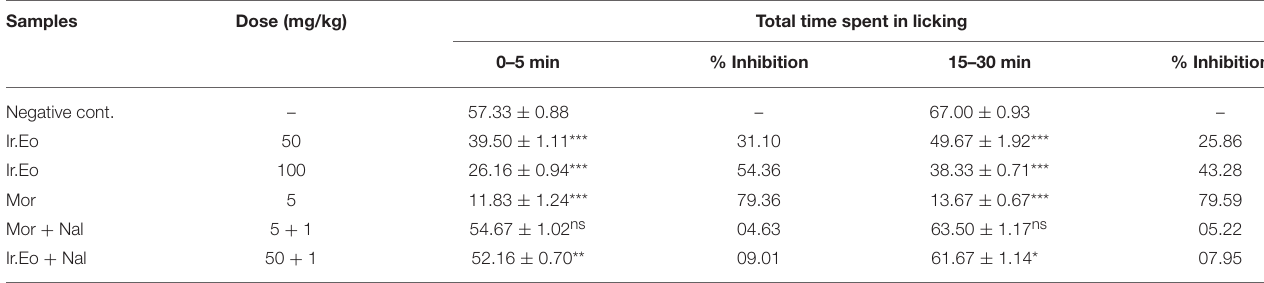
TABLE 4 | Effect of Essential oil of Isodon rugosus on hot plate induced pain in mice. Samples